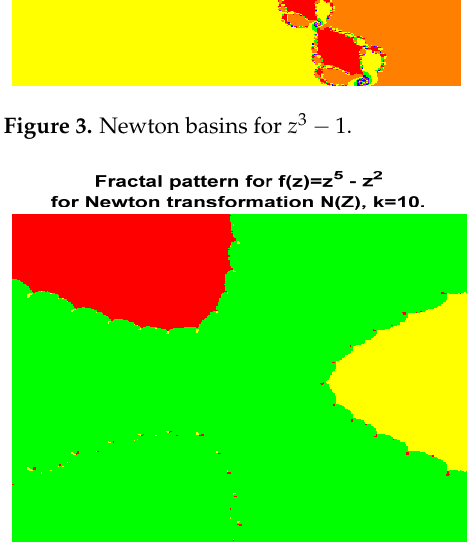
5 2 z Figure 4. Newton basins for z 5 − z 2 5 2 z